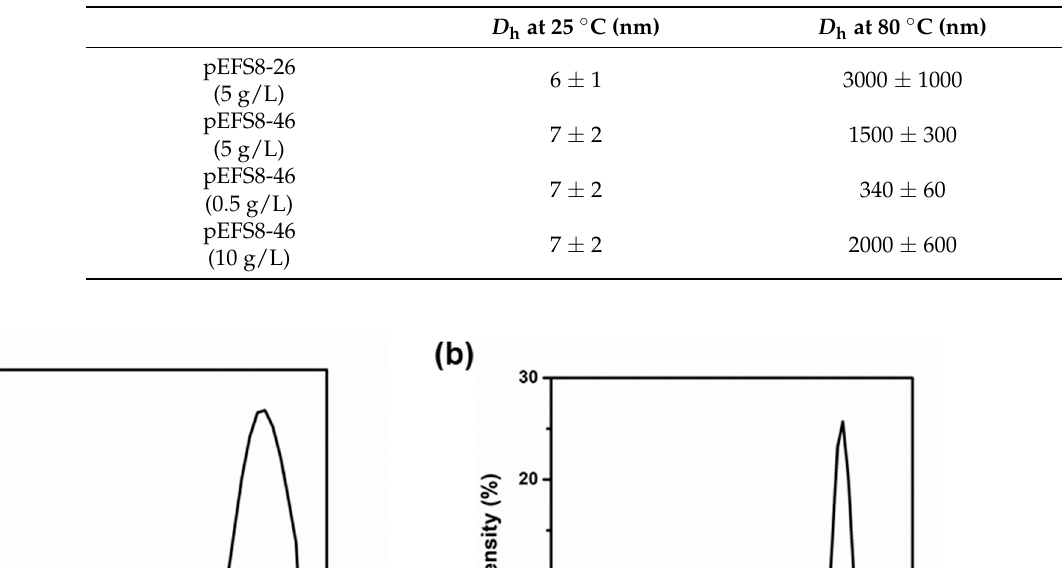
Table 2. Values of hydrodynamic diameters D h (mean value ± standard deviation) for pEFS8-x polymers.